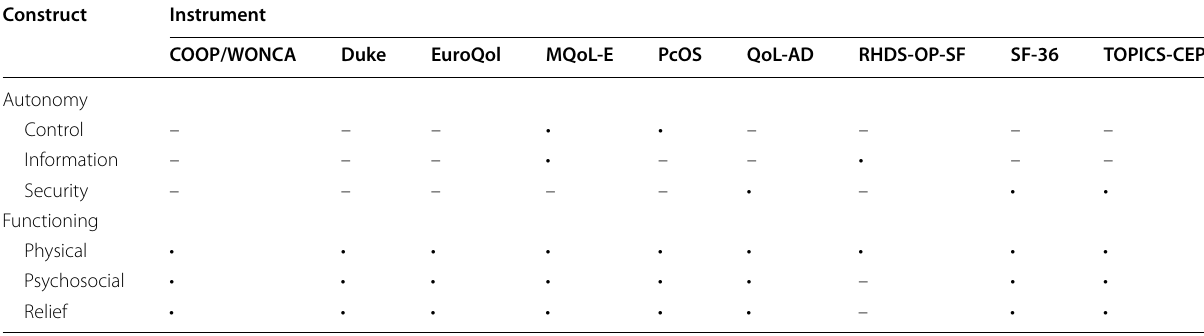
The acute healthcare outcome goals were defined and classified in previous qualitative work [5]